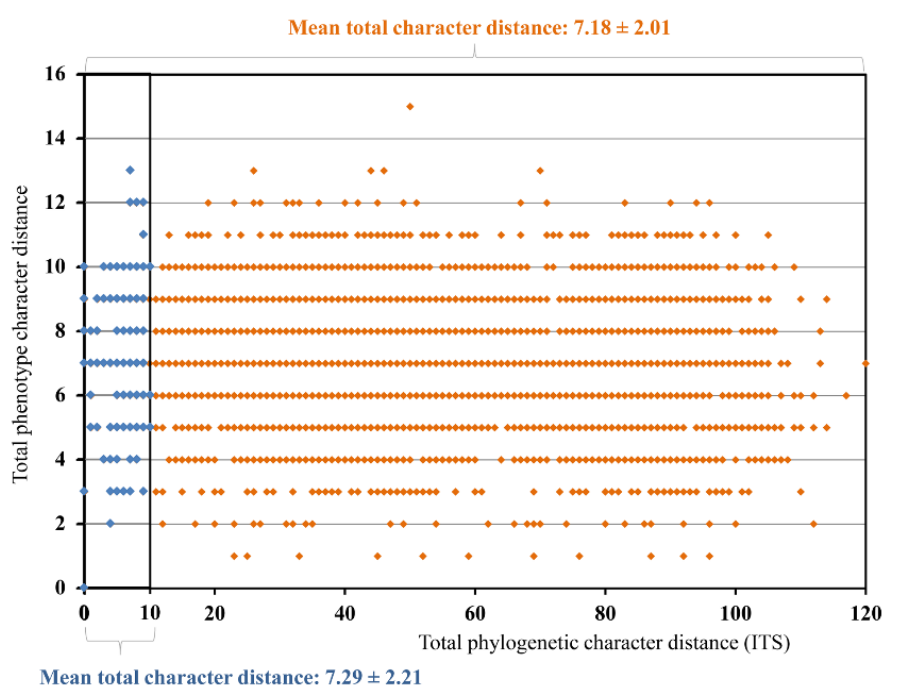
Figure 9. Distance between possible pairs of species for ITS (0–120 bp substitutions), and phenotype (0–16 characters steps). Blue dots on the left side of the graph correspond to closely related species pairs only, orange dots to all other species pair comparisons.